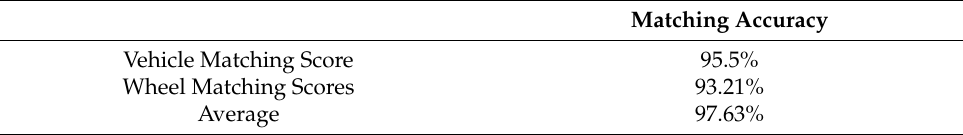
Table 6. Average fusion network performance on test data.